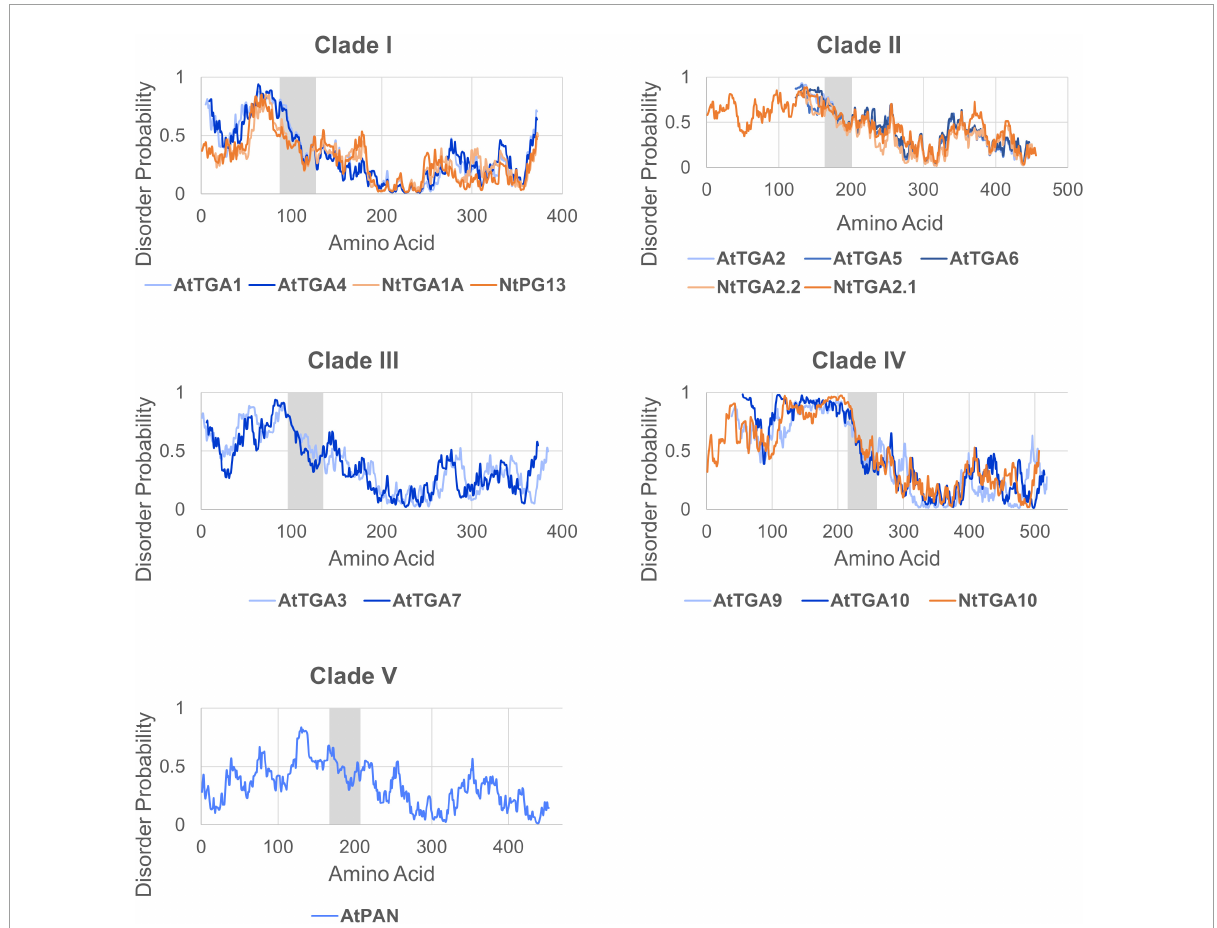
FIGURE3 The N-termini of TGAs are intrinsically disordered. Representation of intrinsic disorder regions of full-length TGA amino acid sequences from Arabidopsis and tobacco, created based on IUPred2 prediction algorithm results (Mészáros et al., 2018). The N-termini of analyzed TGAs show generally high ( > 0.5), yet clade-specific pattern of intrinsic disorder probability, while the disorder probability is considerably lower in their C-termini. Charts representing TGAs from the same clade were aligned based on the conserved bZIP domain, which is shown as grey